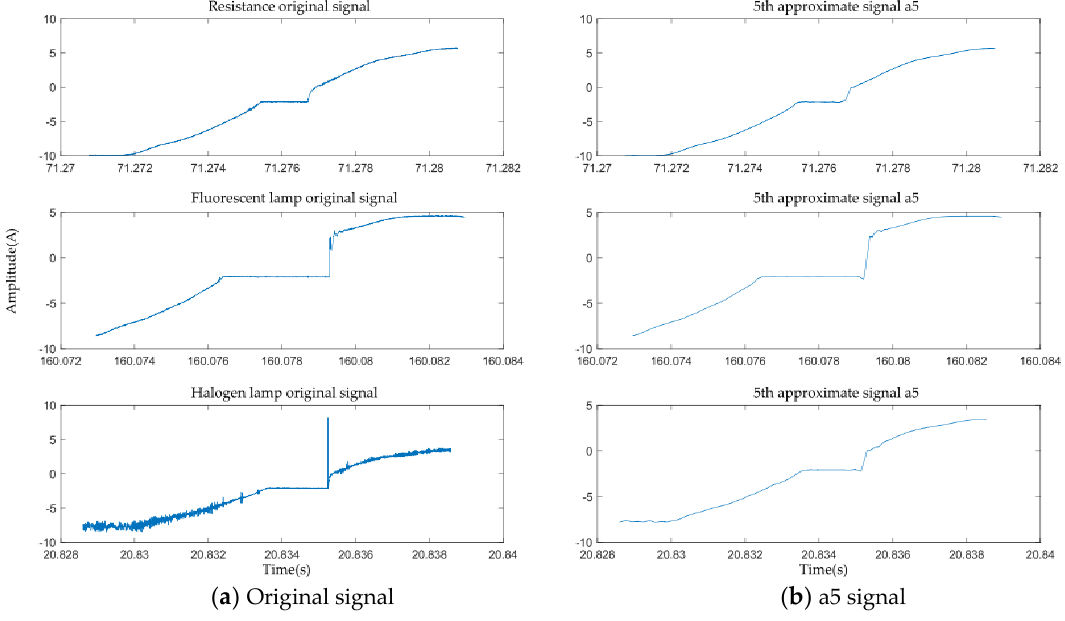
Figure 6. The half-period comparison of the original signal and the approximate signal of the load.